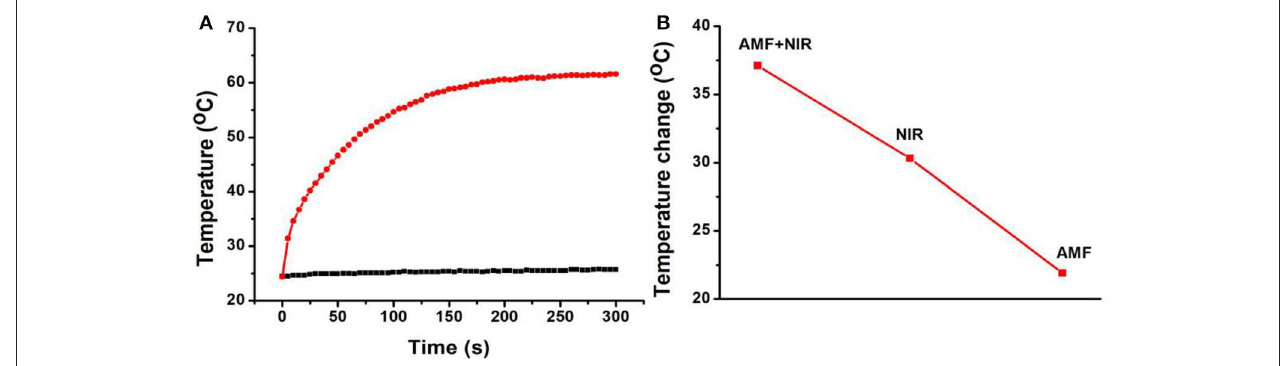
FIGURE 4 | (A) Temperature change of Fe 3 S 4 nanoparticles under co-stimulation of NIR and AMF for 5min. (B) Comparison of the temperature change from the indicated conditions. Fe